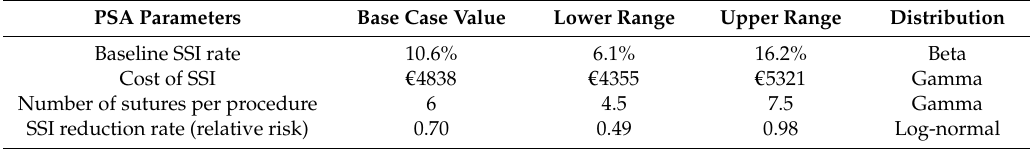
Table 1. Parameters and respective distributions considered in the probabilistic sensitivity